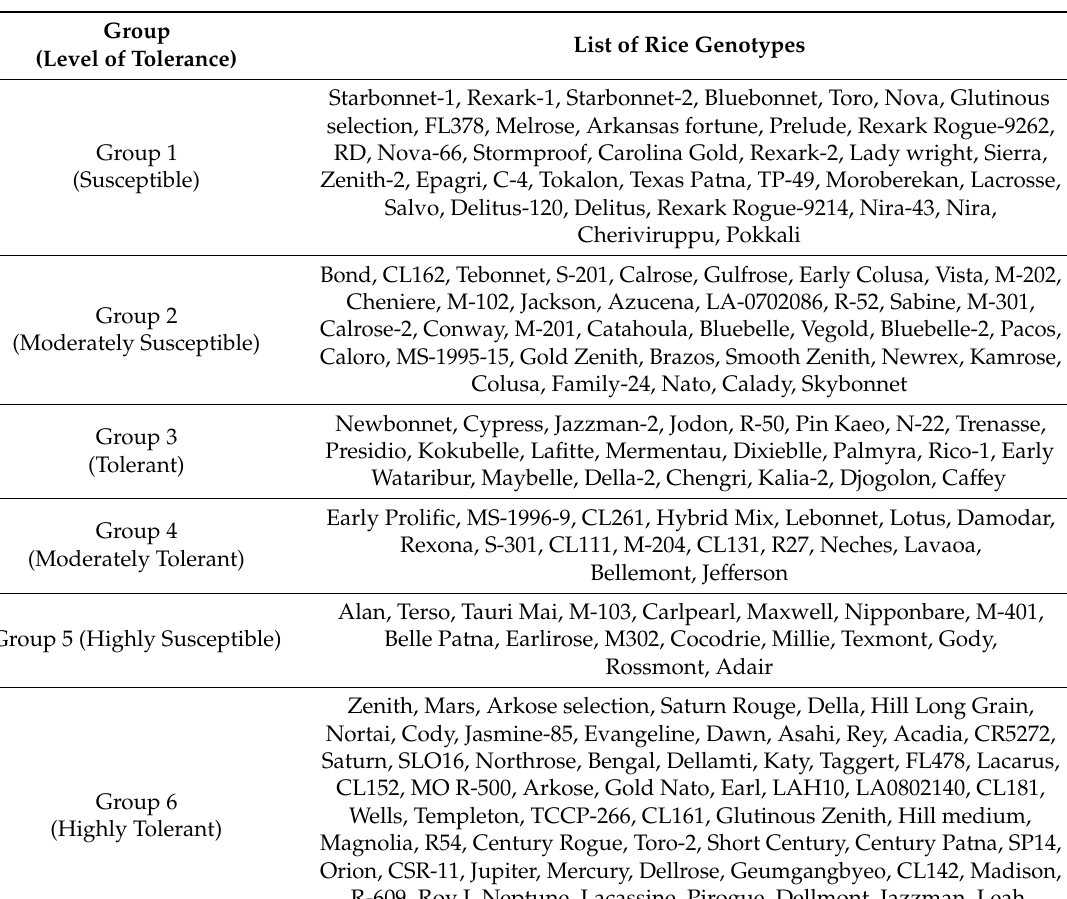
Table 4. Classification of the US rice genotypes for drought tolerance based on various agronomic traits, yield, and yield-related traits under drought